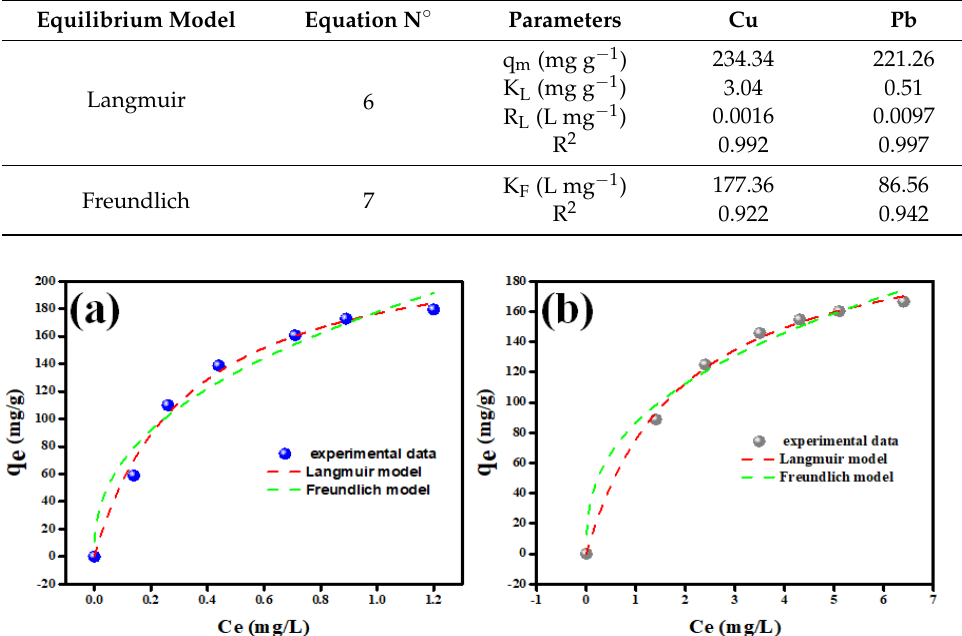
Table 2. Equilibrium isotherm models for Pb(II) and Cu(II) adsorption onto MgO nanorods. Equilibrium Model